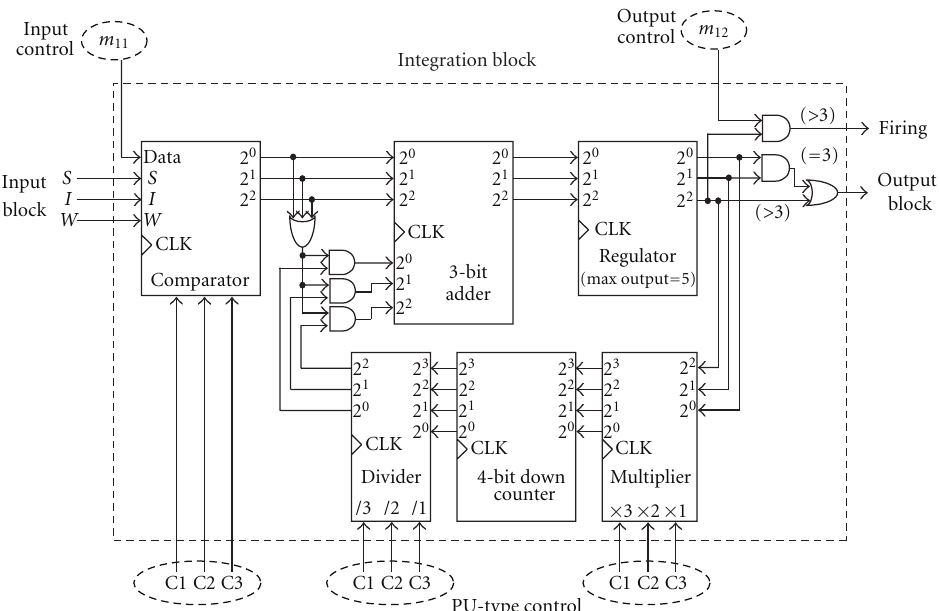
Figure 6: Conceptual architecture of the integration